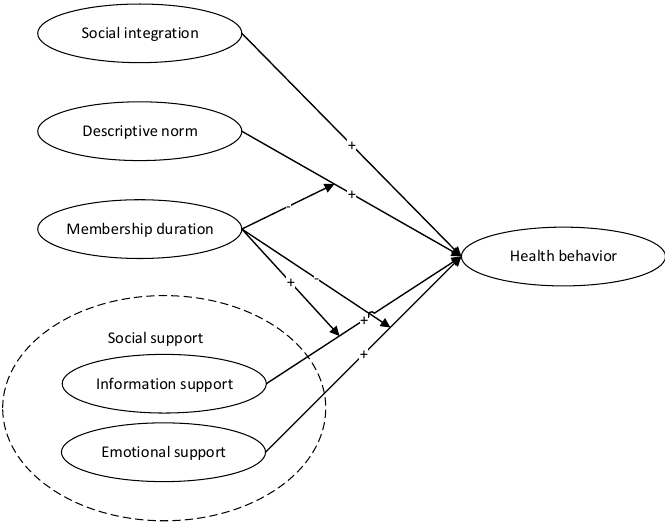
Figure 1. Conceptual f ramework.